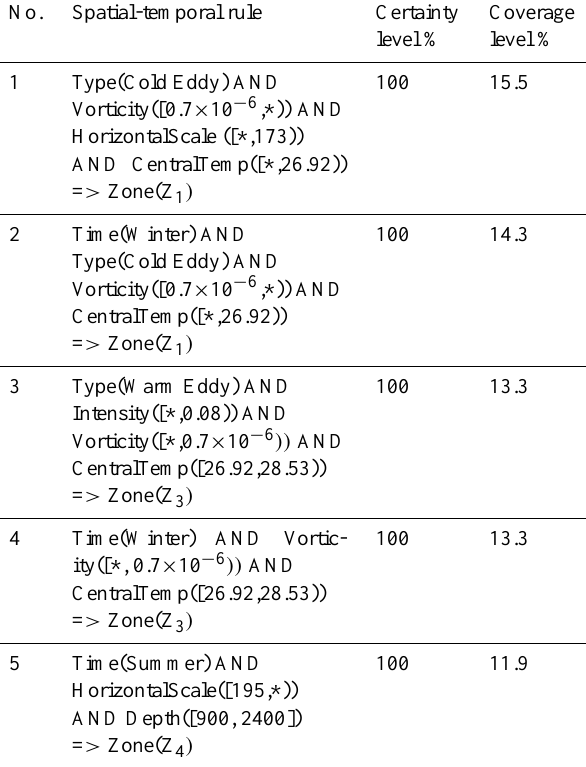
Table 5. Spatial-temporal rules extracted from typical mesoscale- eddy states in 4 zones of the SCS.